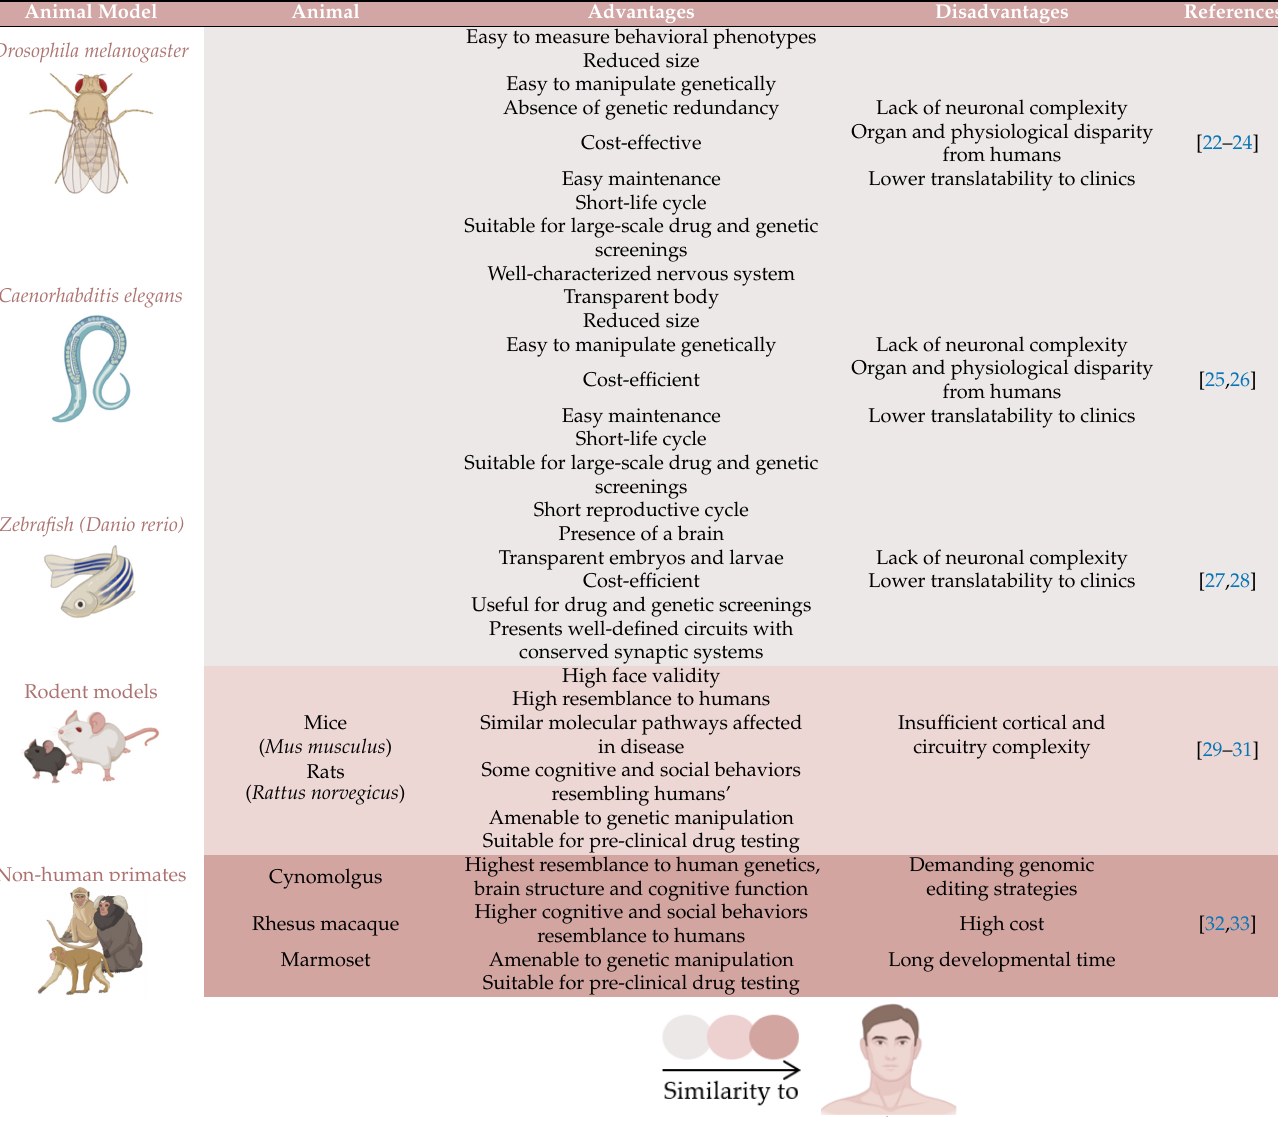
Table 1. Comparison between the different animal models available to study NDDs and their degree of similarity to humans.